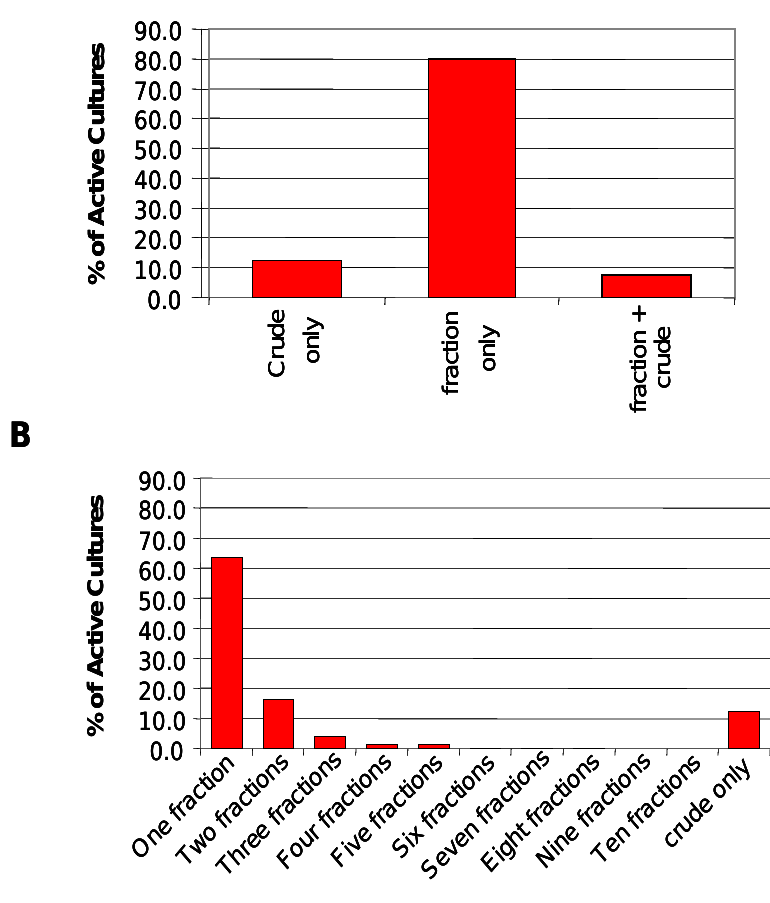
Figure 4. Distribution of the hits from nine HTS screens. A) General categorization of the HTS hits based on activity localization for 1882 active cultures. B) Detailed view of the activity distribution of the hits for the 1882 active